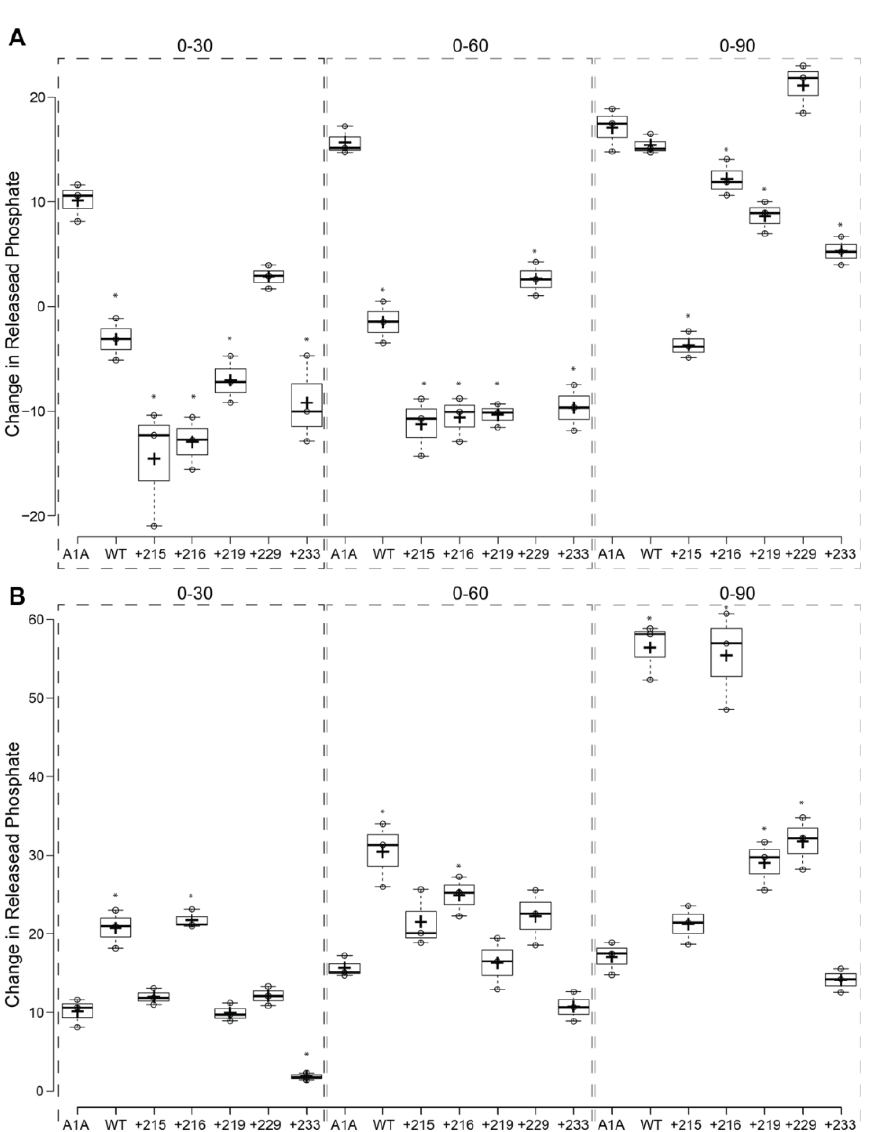
Figure 13. Wild type (WT) BAG-1 and its mutated variants alter in different ways the ATPase activity of recombinant HSPA1A. Two different ( A : 0.5 μM and B : 2 μM) concentrations of BAG -1 (WT and mutants) were incubated with the same amount of HSPA1A (1 μΜ ) in the presence of ATP. The data are presented as the change of released phosphate of three different time points (30, 60, and 90 min) from the released phosphate at time 0. Centerlines show the medians; box limits indicate the 25th and 75th percentiles as determined by R software; whiskers extend 1.5 times the interquartile range from the 25th and 75th percentiles; crosses represent sample means; dots represent individual data points. The Y-axes values are not the same between the two panels. Each experiment was repeated three times. Significantly different values are denoted with a star (*). The actual p -values between all comparisons are provided in Supplementary Materials Table S2.